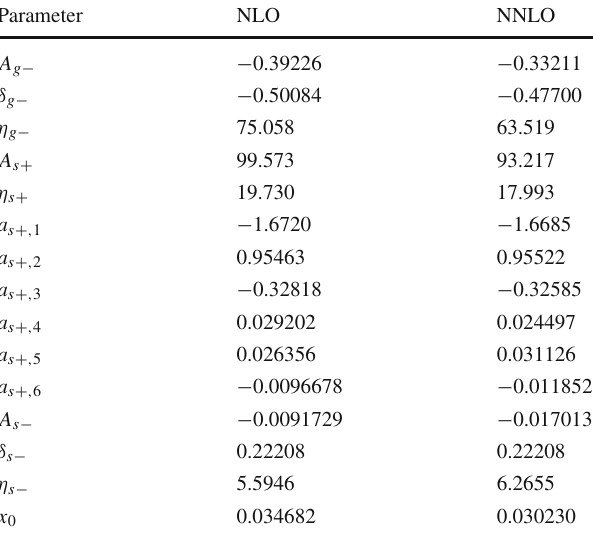
Table 8 The optimal values of the input PDF parameters (as defined in = 1 GeV 2 determined from the global analyses for Sect. 2.1) at Q 2 0